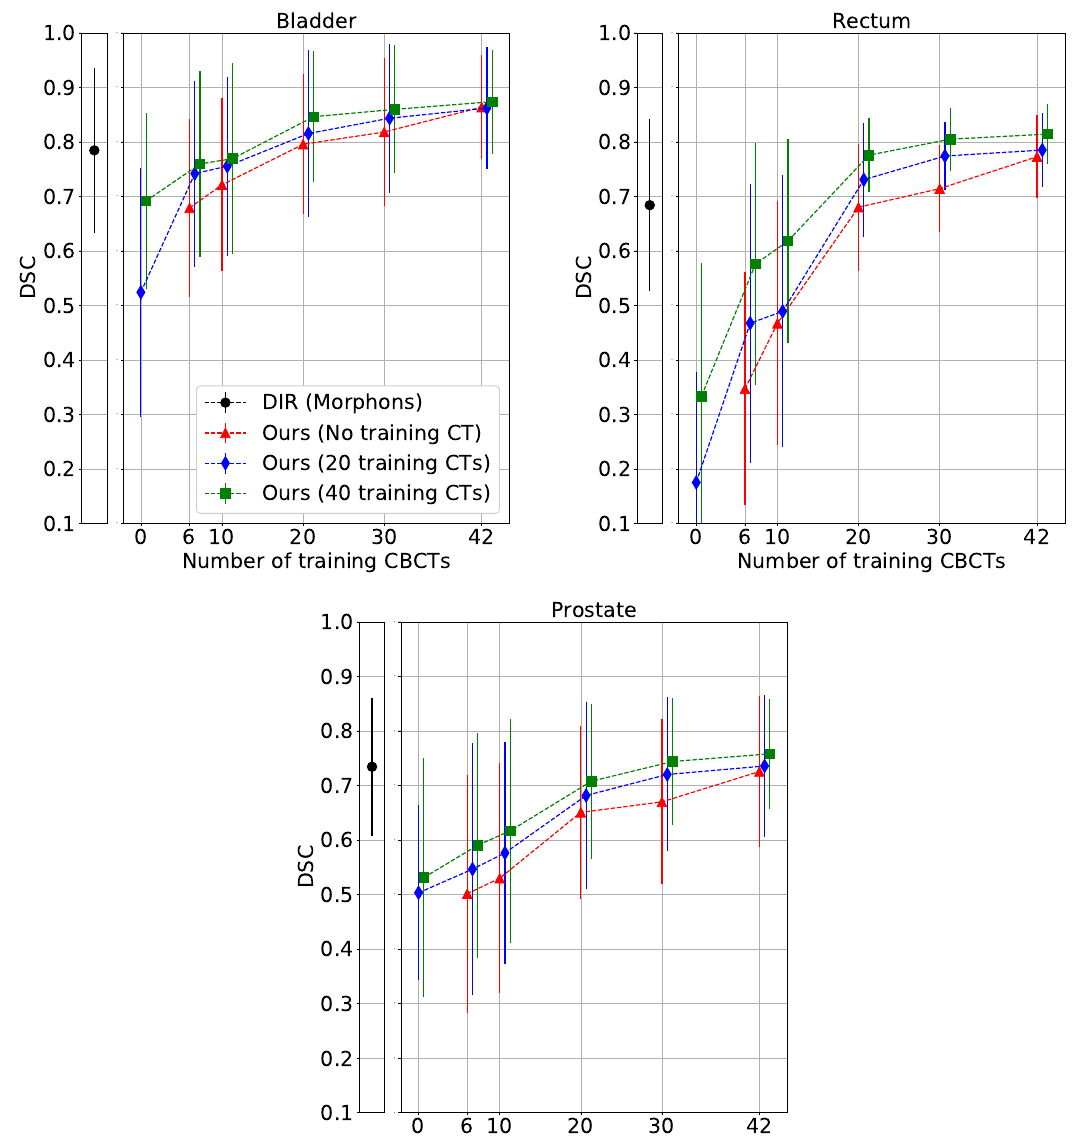
Figure 4. Influence of the number of training CBCT and CT scans on the DSC. Bars indicate one standard deviation for the group of 63 patients. DSC: Dice similarity